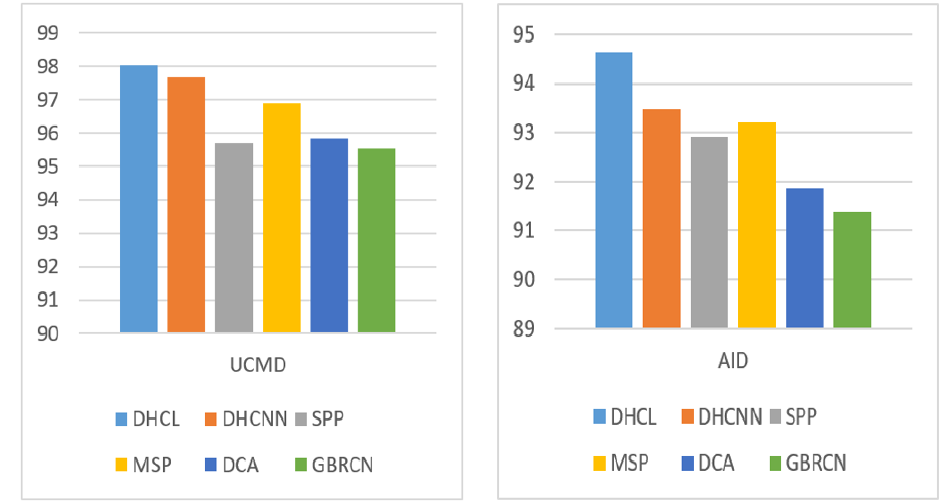
Figure 8. Classification accuracy on UCMD and AID. We use DHCNN, SPP, MSP, DCA and